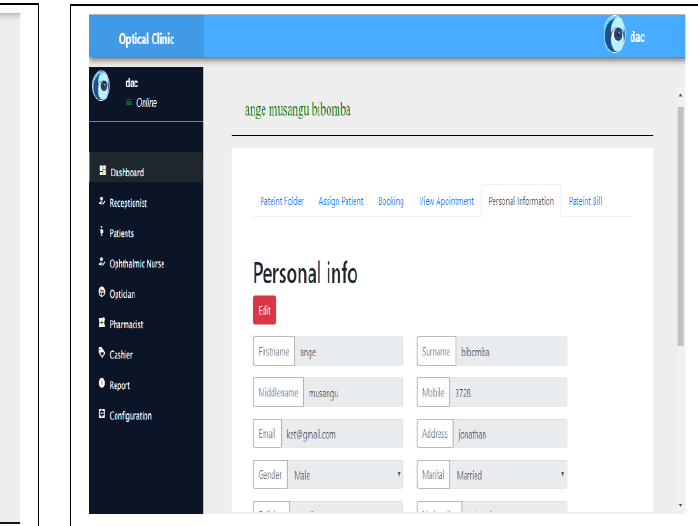
Figure 21. Receptionist Search Interface